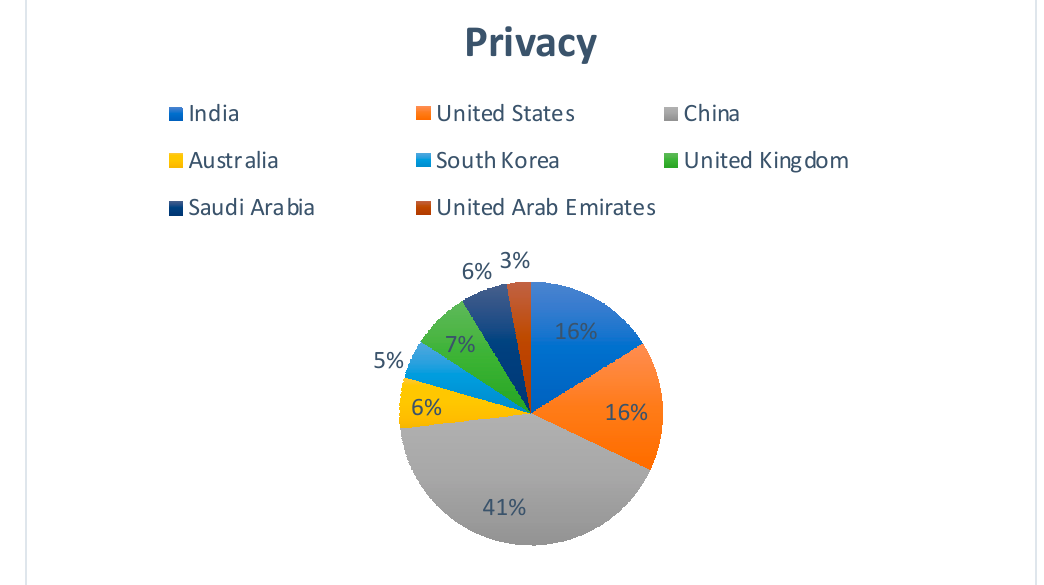
Figure 12. Region-specific publication distribution for the impact of Blockchain–Cloud integration on Privacy in Cloud.